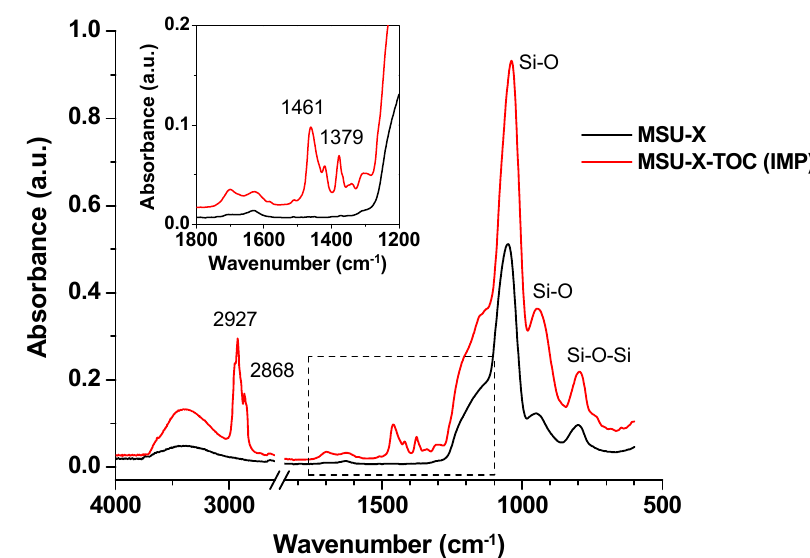
Figure 1. FTIR spectra of MSU-X and MSU-X-TOC (IMP) materials.